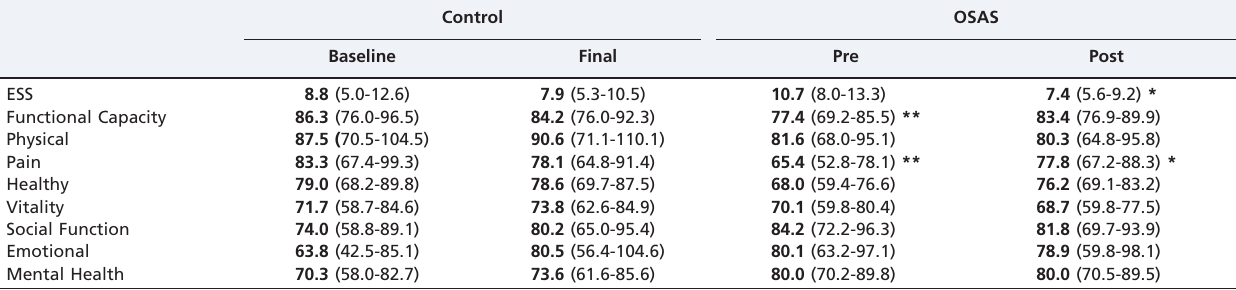
Table 3 - Baseline and final measures for sleepiness and quality of life for the control and obstructive sleep apnea syndrome (OSAS) groups.